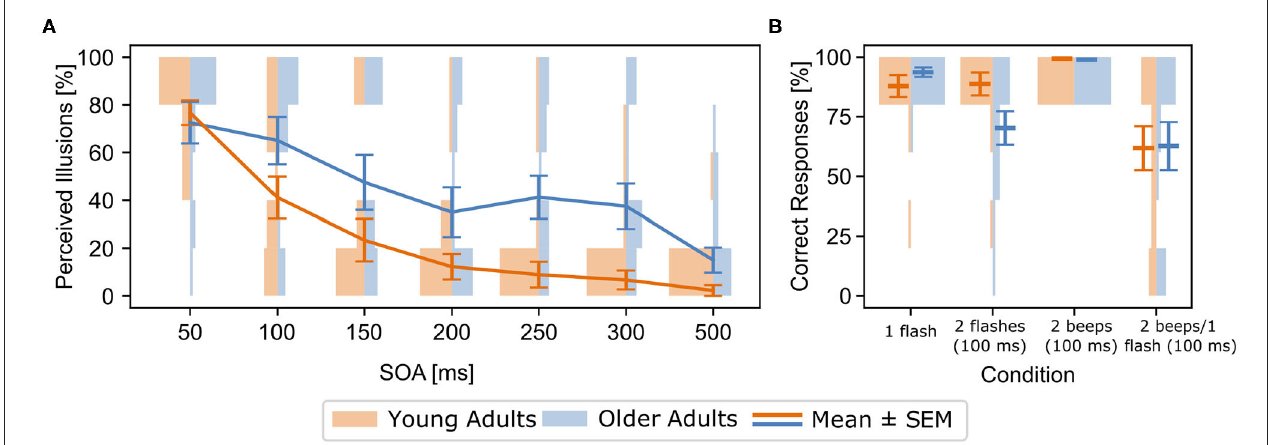
FIGURE 2 | (A) [Behavioral results for the 2 beeps/1 flash condition (means and standard errors (SEM))] Rates of perceived illusions in the experimental setup outside the MEG for all stimulus-onset asynchronies (SOA) and both age groups (blue: older adults, orange: young adults). Line graphs show means and standard errors (SEM), histograms show distribution of rates for each group and SOA. Rates denote incorrect responses (i.e., perceived illusions) in the 2 beeps/1 flash condition. Older adults perceived more illusions across the 100-500 ms SOA conditions, compared to young adults. (B) Behavioral results from within the MEG for both groups and all experimental conditions. Line graphs show means and SEM, histograms show distribution of rates for each group and condition. Rates denote correct responses for each condition. Note that incorrect responses in the 2 beeps/1 flash condition indicate the perception of an illusions.